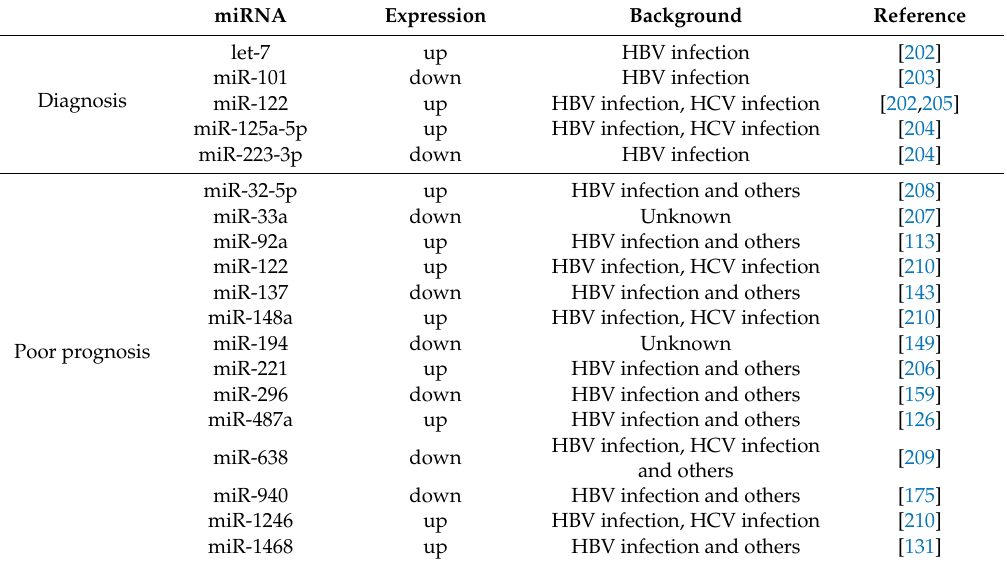
Table 4. Recently reported miRNAs as biomarkers for